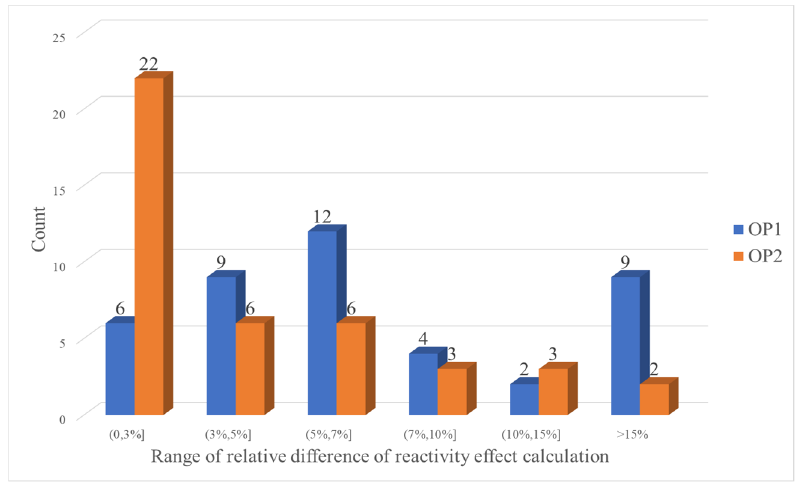
Figure 9. Summary of all the numerical results.